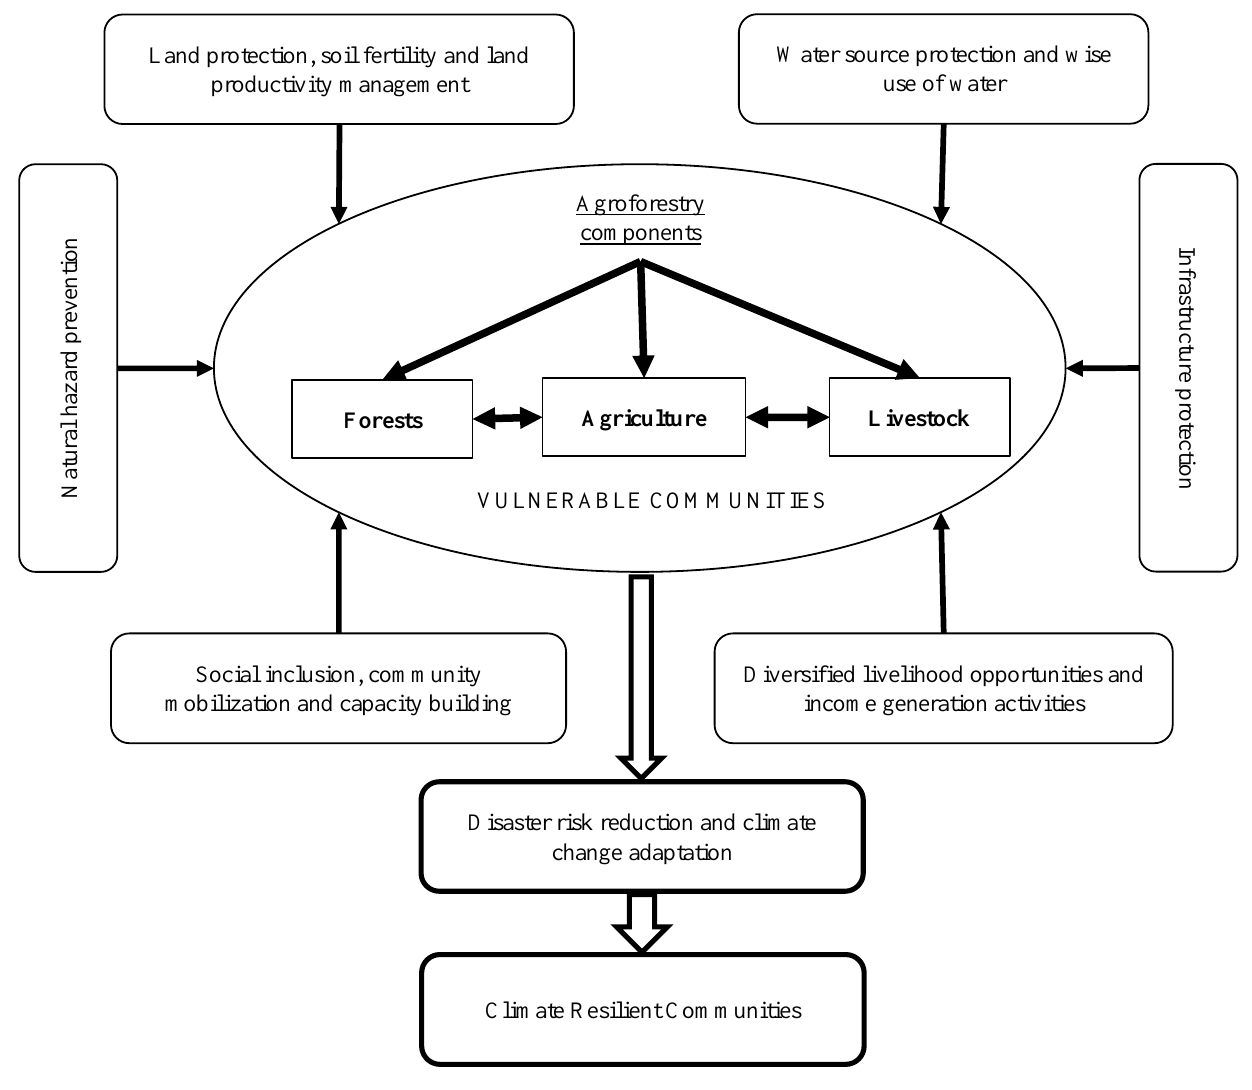
Figure 2. Package-based agroforestry in